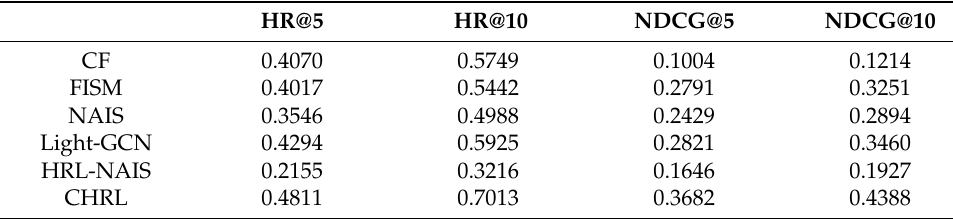
Table 4. Recommendation performance on Goodbooks